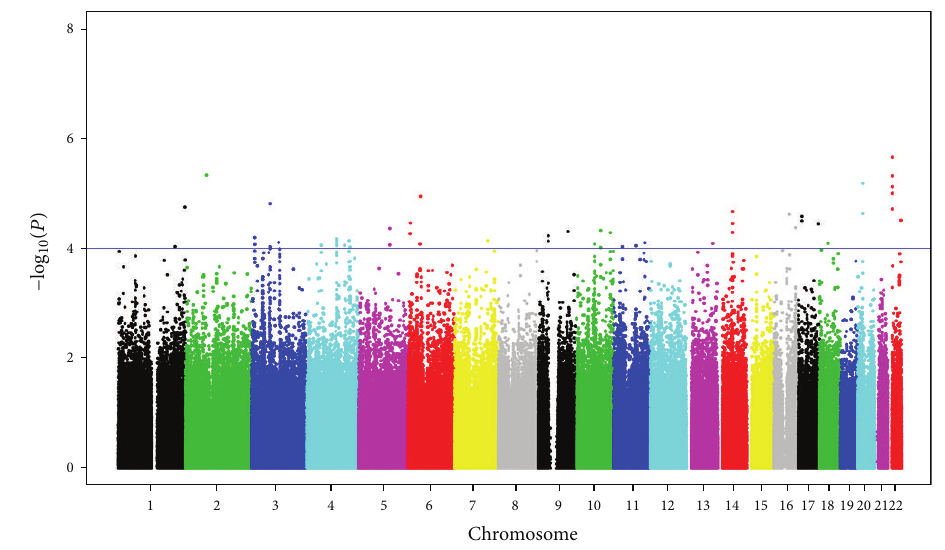
Figure 3: Manhattan plot showing the genome-wide association 𝑃 values with lupus anticoagulant (LAC). Blue line indicates 𝑃 = 1𝐸 − 04 .